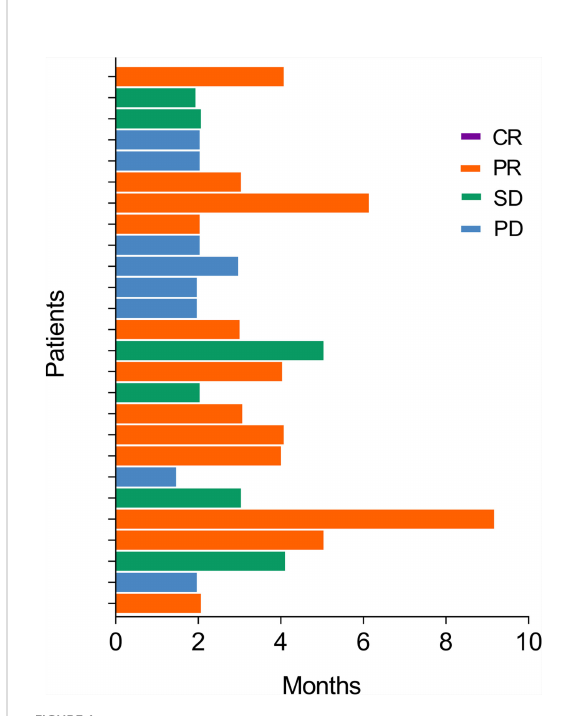
FIGURE 1 Swimmer plot showing the response status of each BTC